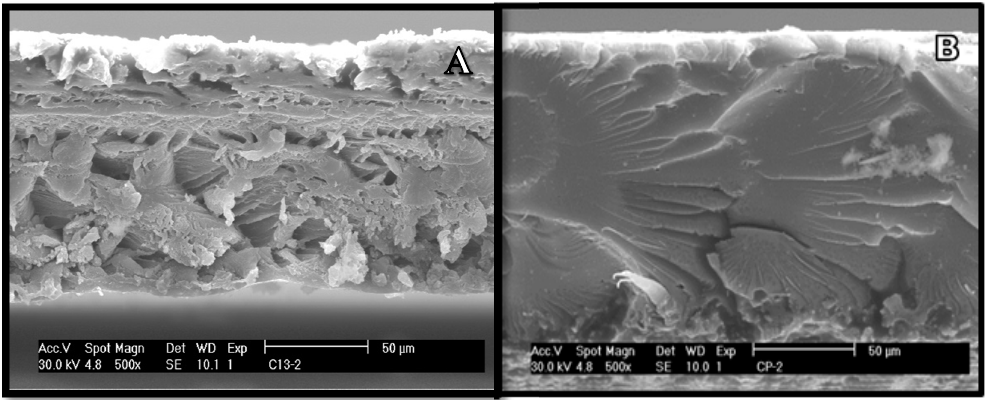
Figure 2. Scanning electron microscopy (SEM). ( A ) Edible film, ( B ) Edible film with F. cernua extract.